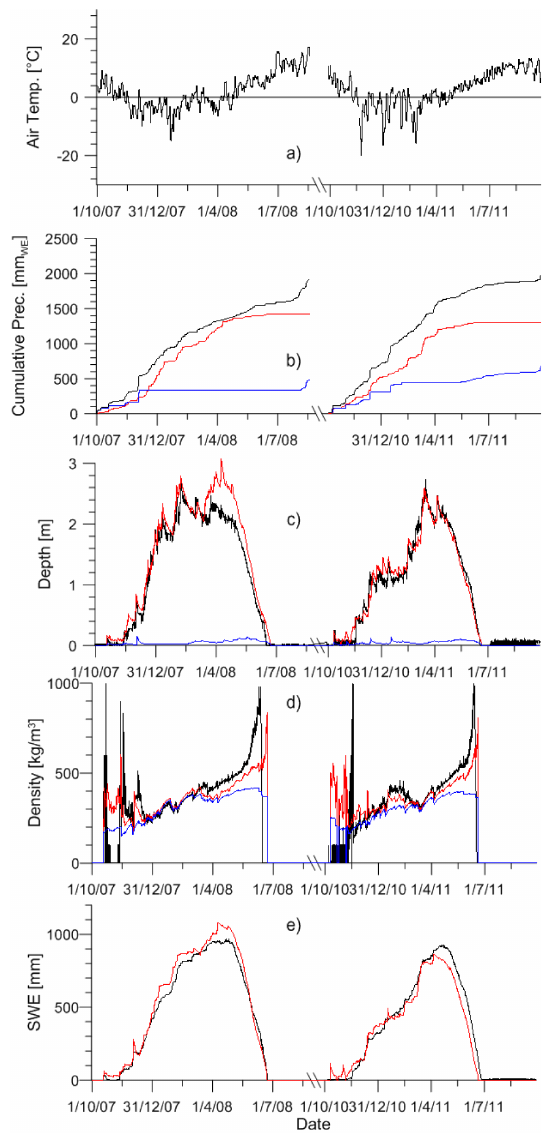
Fig. 2. Meteorological forcings, and dynamics of depth, density and SWE for S1 and two hydrologic years: 2007–2008 (calibration) and 2010–2011 (validation). (a) Air temperature, (b) cumulative pre- cipitation, total observed in black, liquid modeled in blue and solid modeled in red, (c) depth h in red modeled and in black observed, and h W in blue, (d) density ρ in red modeled and in black observed and ρ D in blue, and (e) SWE in red modeled and in black observed.